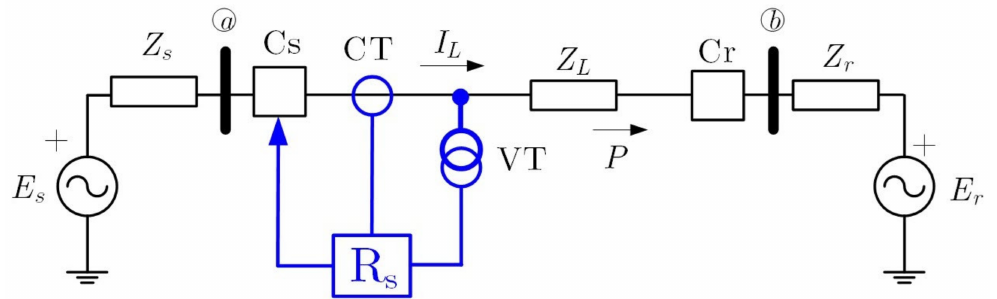
Figure 1. A two equivalent generators power